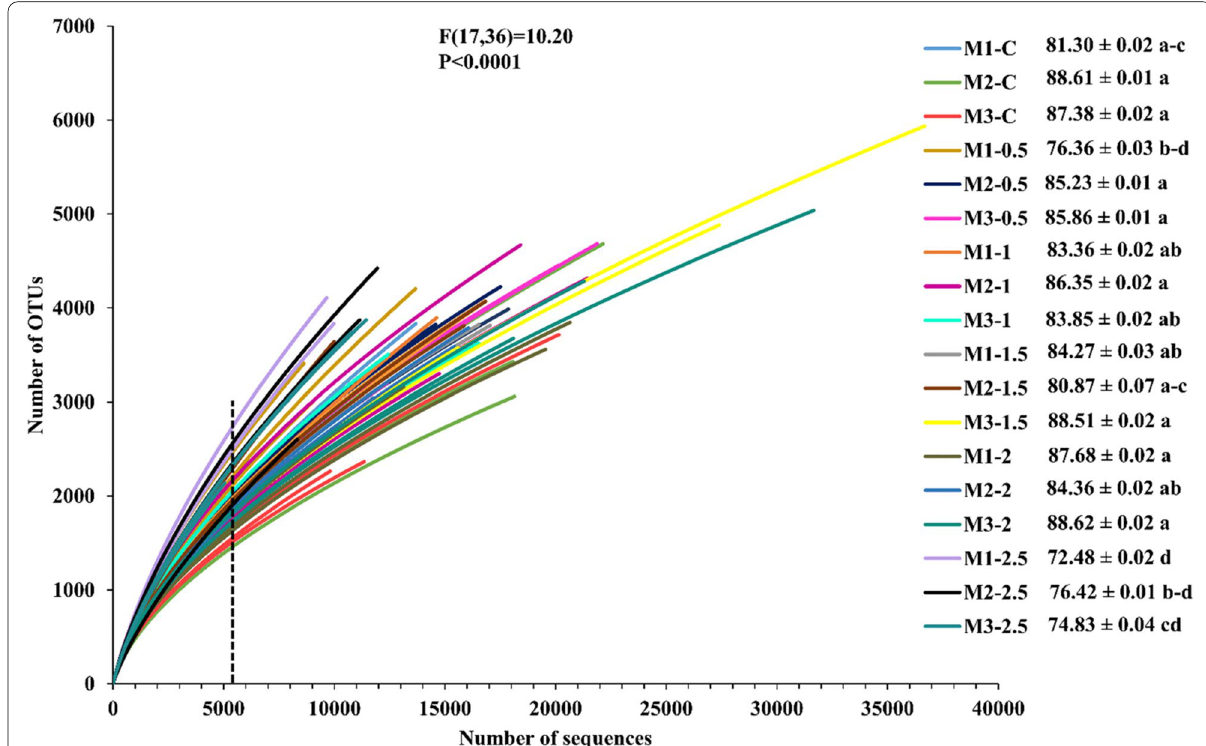
Fig. 1 Rarefaction curve of bacterial communities and Good’s coverage estimates (% standard deviation) in the non-amended and ± sclerotia-amended soil samples of rice-rapeseed rotation field soil amended with different doses of R. solani sclerotia. M1, M2, and M3 represent 1 st month, 2 nd month, and 3 rd month while C shows the non-amended samples. Moreover, 0.5, 1, 1.5, 2 and 2.5 denotes the different dose of sclerotia in gram amended in soil. The dotted line represents the number of sequences used as a subsample (5400 sequences) for alpha diversity estimates. ANOVA followed by Tukey–Kramer post hoc comparisons was performed using R. Effect of amended and non-amended soil (F(dfn, dfd) and P-value) represented at the top of the graphs while lowercase letters indicate significant differences (P < 0.05)